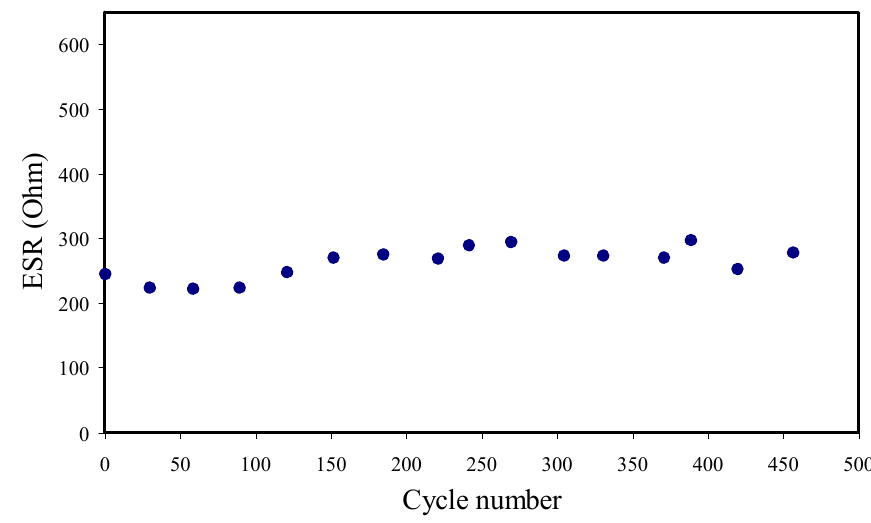
Figure 12. Equivalent series resistance (ESR) of the EDLC device for 450 cycles at RT. The specific capacitance ( C d ) from the galvanostatic charge-discharge (GCD) is mea- sured using Equation (25) [3]: